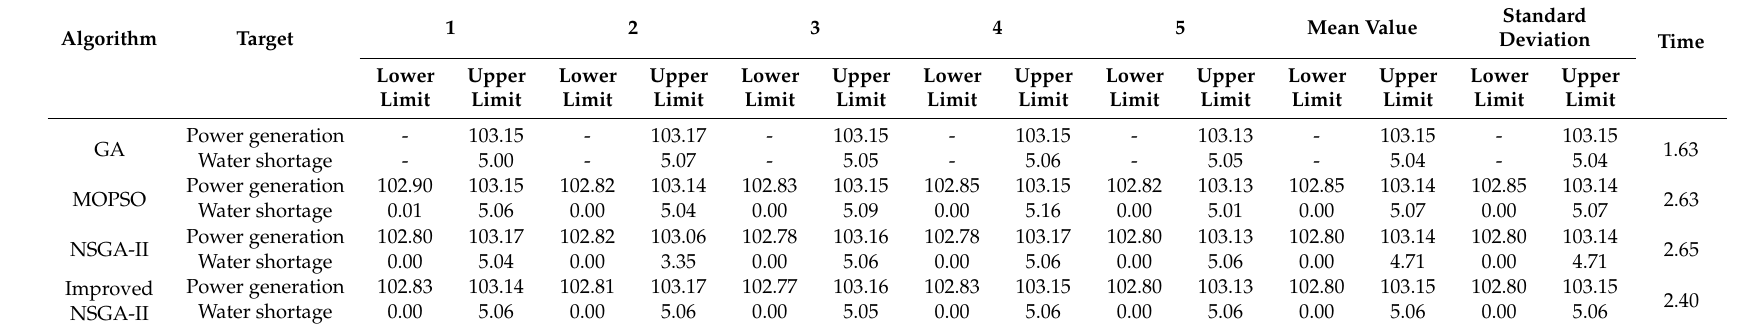
Table 3. Comparison of statistical parameters of each target with di ff erent calculation